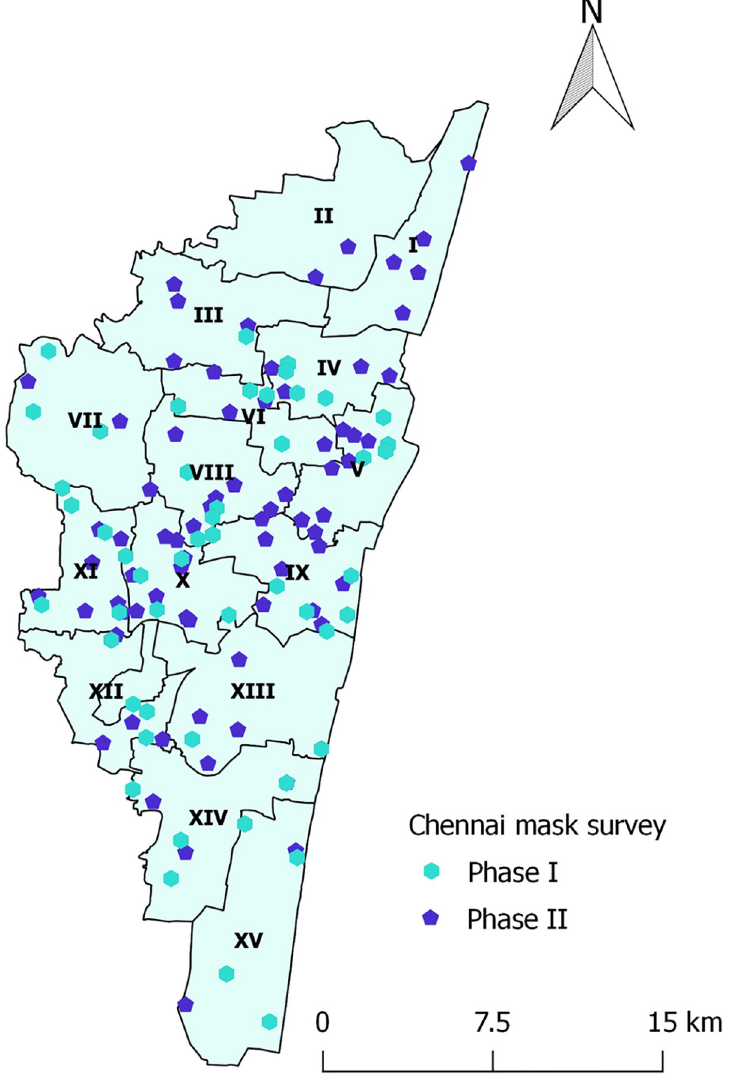
Fig 1. Study sites of mask survey, Chennai, India, October-December